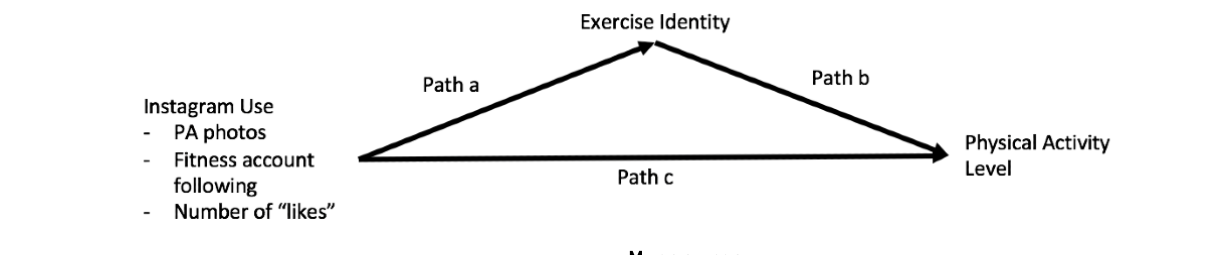
Figure 1. Hypothesized mediation model including Instagram use, exercise identity, and physical activity